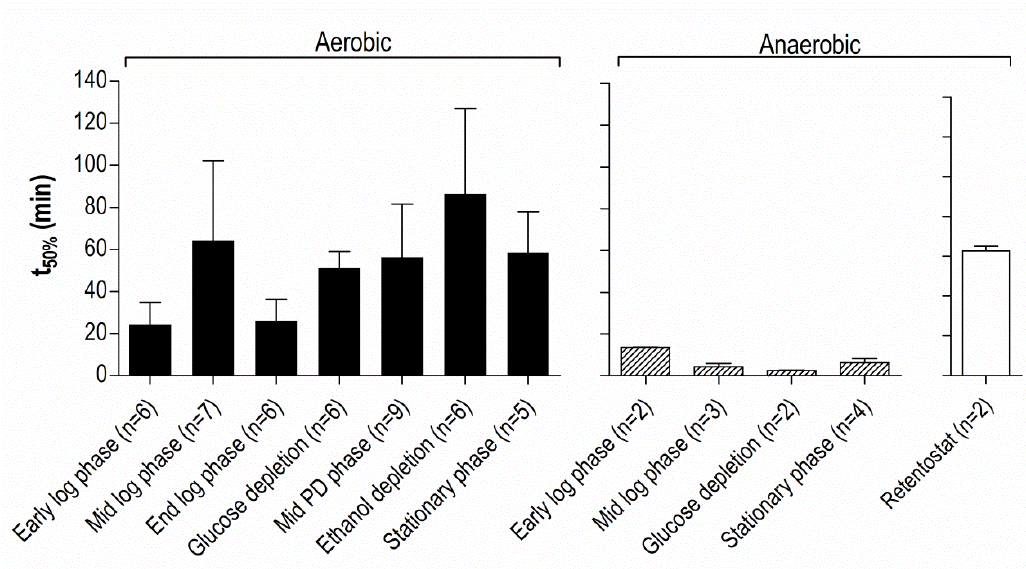
FIGURE 5: Thermotolerance of aerobic and anaerobic cultures during different growth phases. Thermotolerance of cells during different growth phases of aerobic ( black bars ) and anaerobic ( hatched bars ) batch cultures of S. cerevisiae (Figure 4). The white bar depicts the thermotolerance of S. cerevisiae grown for 8 days in anaerobic retentostats [20]. Thermotolerance was assayed by monitoring viability during incubation at 53°C and is shown as the incubation time resulting in a 50% decrease in viability (t 50 ) (see Materials and Methods for more details). The number of independent culture replicates for each of the growth phases is denoted on the x-axis